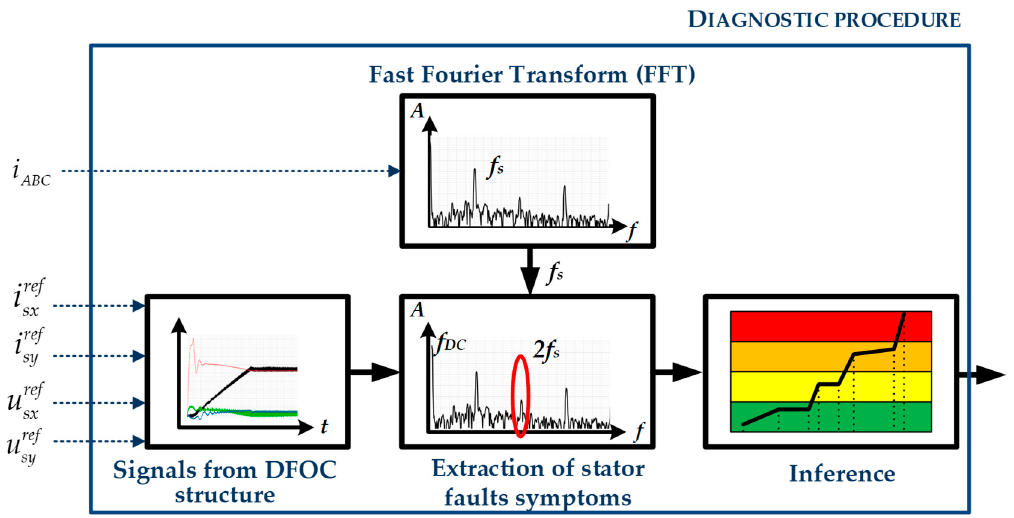
Figure 3. Block diagram of proposed diagnostic procedure.